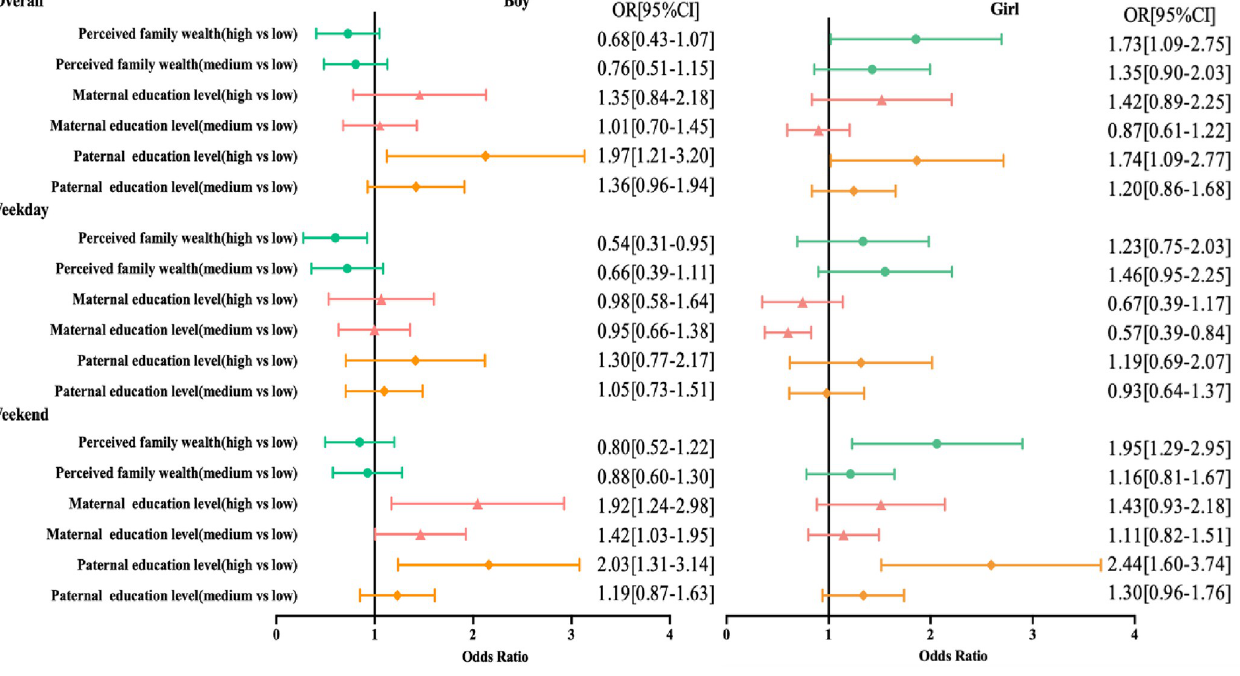
Fig 2. Regression analysis of sex differences in socioeconomic status and screen